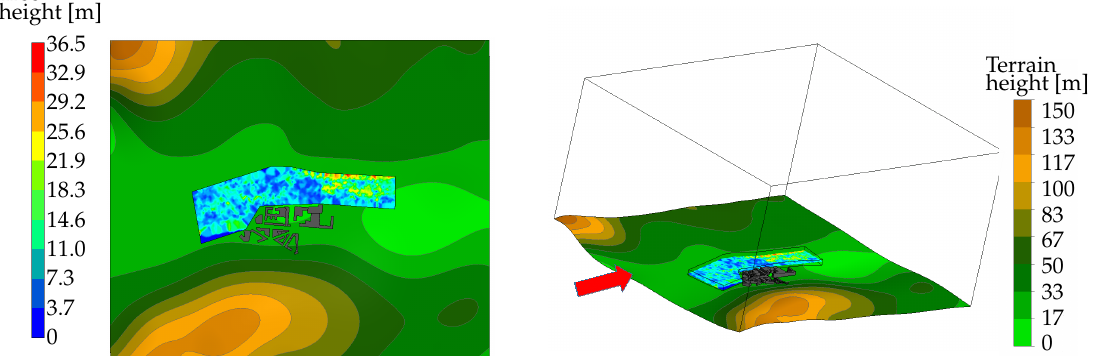
Figure 5. Computational domain from above ( left ) and in a 3D view with dimensions ( right ). Terrain height (legend on the right) is indicated relative to the lowest point in the area. The buildings cover an area of approx. 300m × 600m. Within the polygonal area of approx. 1800m × 350m the trees are modelled in detail. Here, tree height is given relative to the ground (legend on the left). Inflow is from the left, perpendicular to the domain’s face as indicated by the red arrow on the